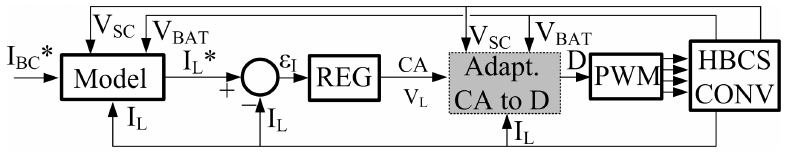
Figure 18. Complete control scheme for the half-bridge current-source (HBCS) converter.